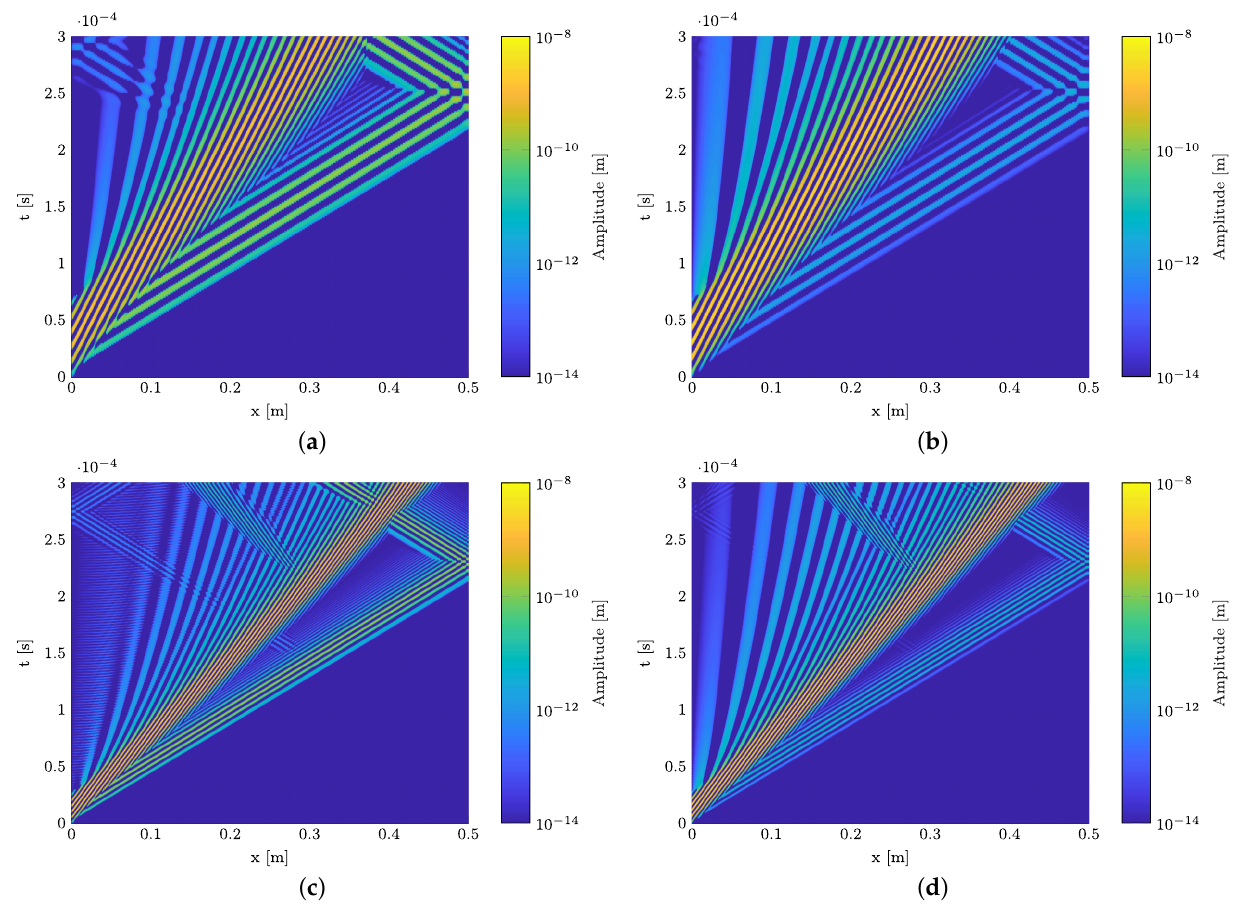
Figure 9. Comparison of the numerically determined wave interaction of GUW with the polyimide inlay in the midplane of the GFRP specimen at different burst center frequencies. The design of the numerical model is depicted in Figure 5. ( a ) In-plane displacement component at 75kHz. ( b ) Out- of-plane displacement component at 75kHz. ( c ) In-plane displacement component at 200kHz. ( d ) Out-of-plane displacement component at